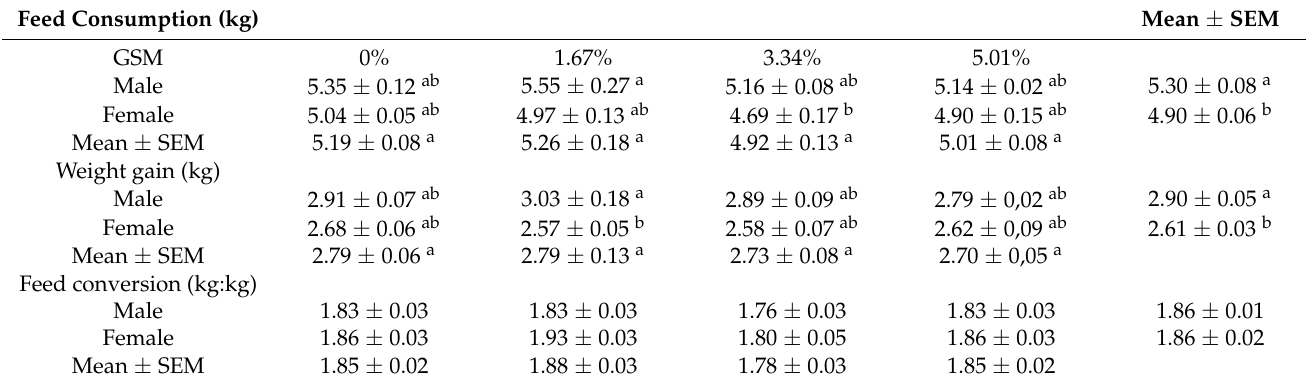
Table 2. Production parameters of the broiler experimental